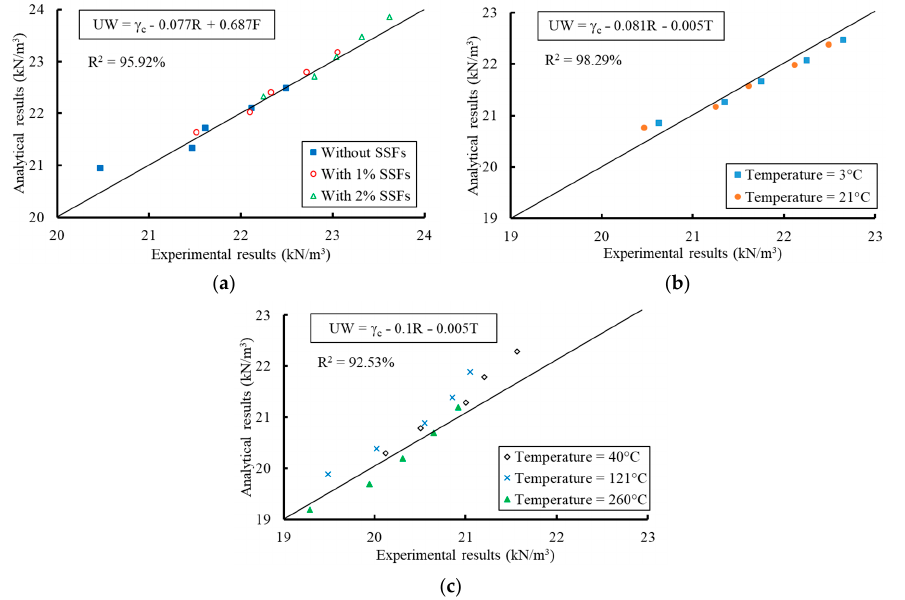
Figure 9. Regression between the experimental and analytical values of the unit weight. ( a ) Case of rubber content. ( b ) Case of rubber content and temperature (3 °C ≤ T ≤ 21 °C). ( c ) Case of rubber content and temperature (T > 21 °C).